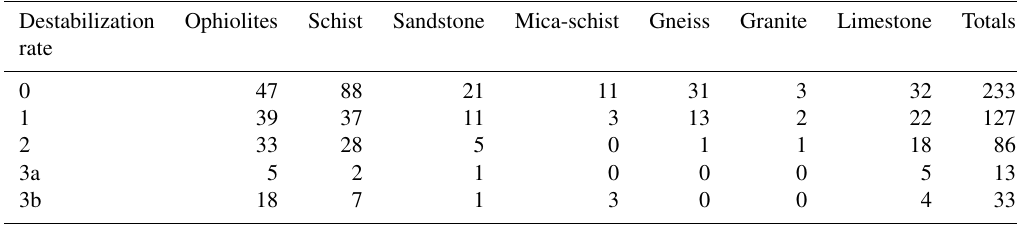
Table 3. Number of rock glaciers per dominant lithology in relation to destabilization rate. Destabilization Ophiolites Schist Sandstone